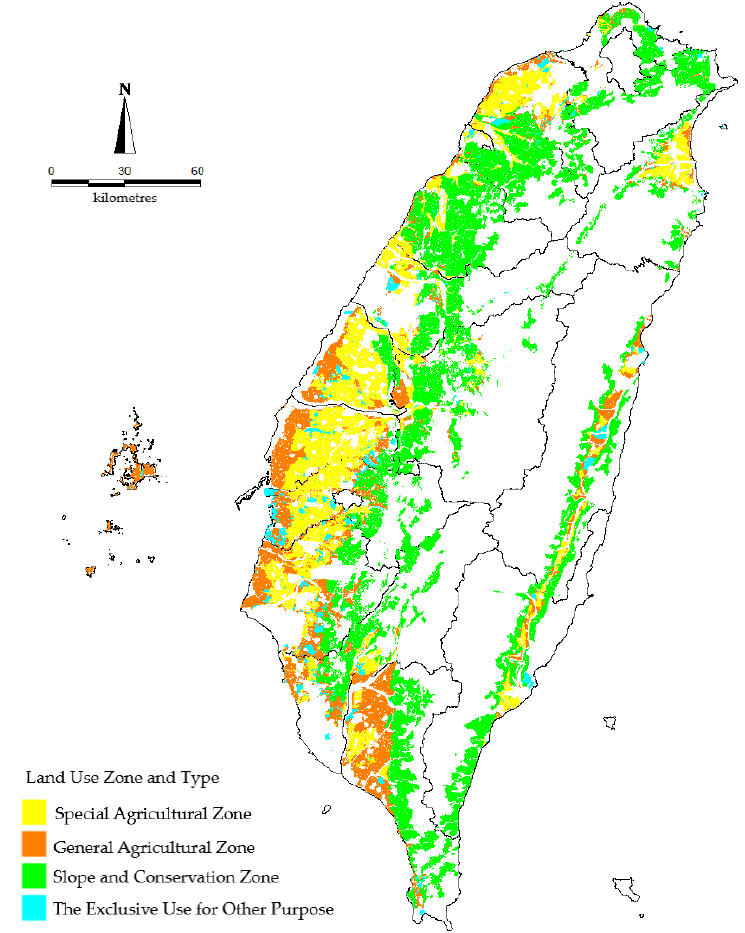
Figure 1. Land use zone-type in non-urban planned districts.